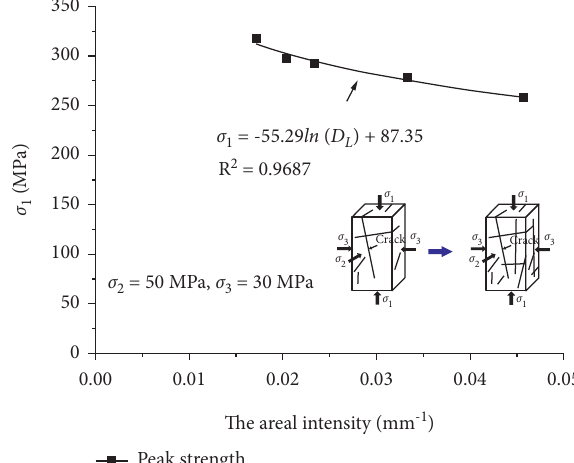
Figure 4: Experimental results of the areal intensity ( D L ) effect on the peak stress of marble containing multiple cracks.